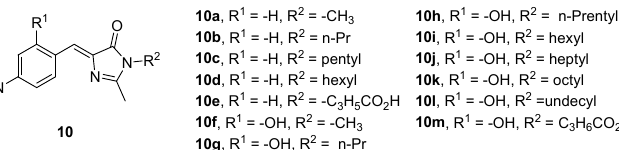
Figure 10. GFPc analogues with enhanced emission intensity in the presence of HSA [24].